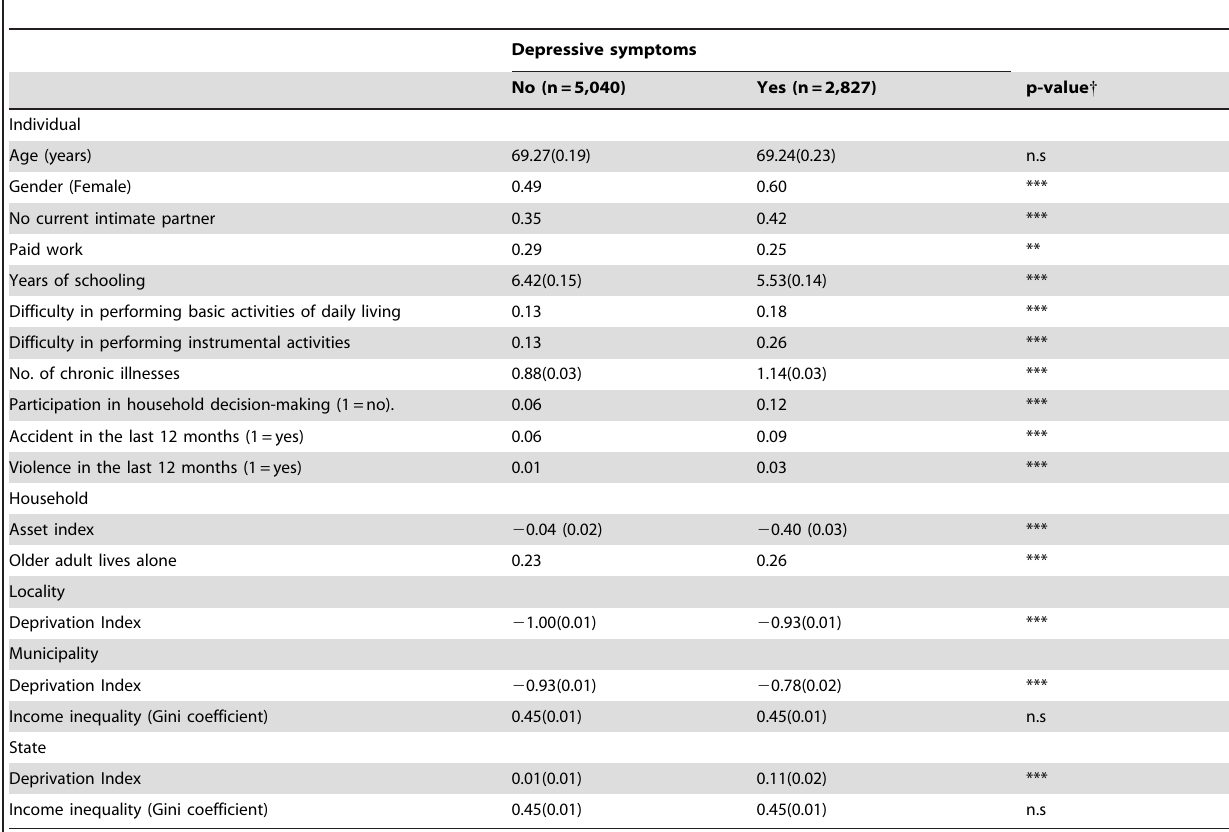
Table 1. Sociodemographic characteristics according to the presence of depressive symptoms in the study sample. `